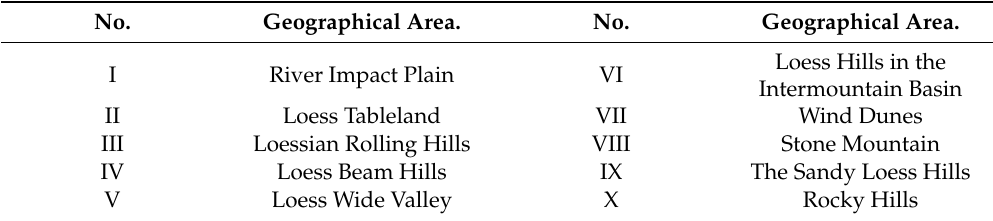
Figure 1. Geographical zoning (Cf. Table 1) map of the Loess Plateau and the distribution of meteorological stations. Table 1. Loess Plateau